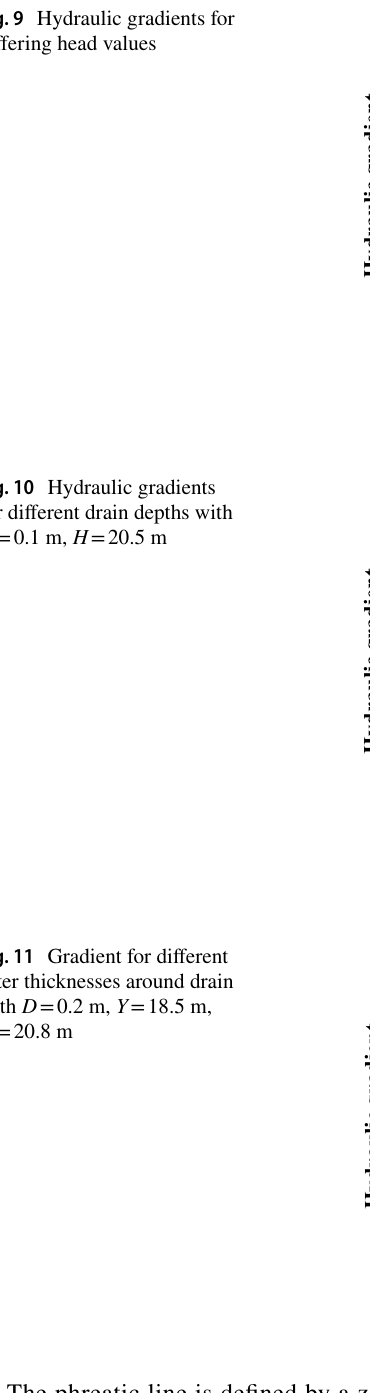
without drain, head= 20.5m without drain, head= 20.8m without drain, head=21.2m